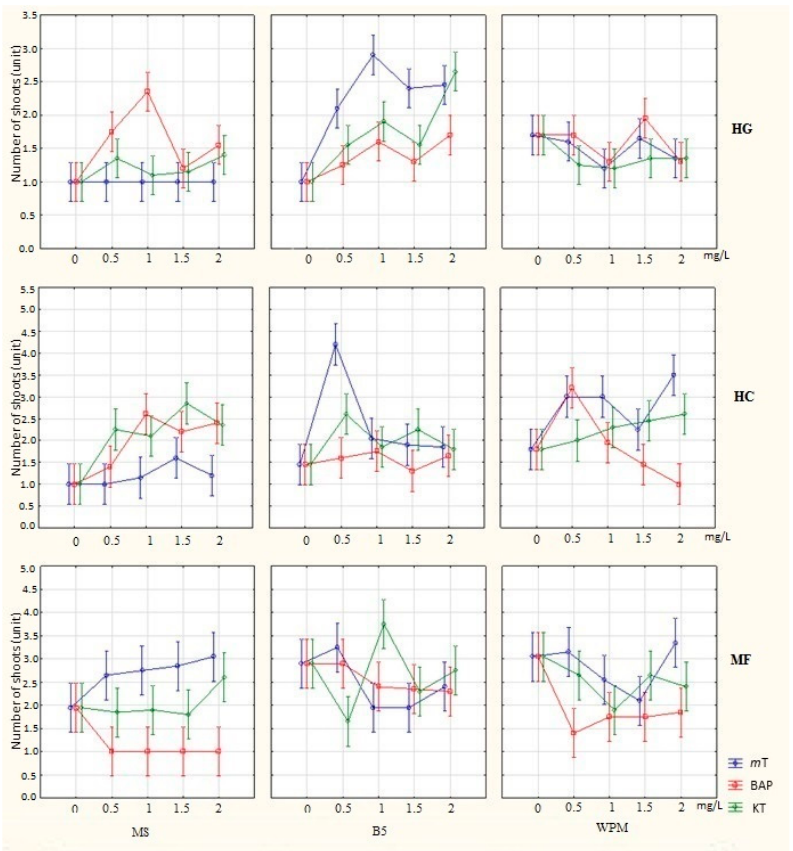
Figure 5. The combined effect of mineral base, growth regulator, and growth regulator concentra- tion on the average number of H. grandiflorum (HG) , H. cretaceous (HC), and M. fragrans (MF) shoots in vitro . Confidence interval = 0.95.